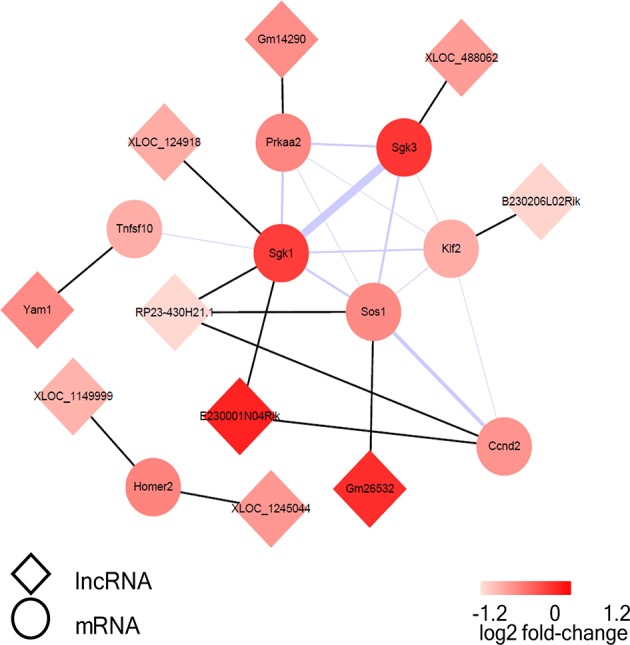
The visualization of the lncRNA/FoxO gene co-expression network in FoxO pathways. The circular nodes represent the FoxO-genes, and the diamond nodes represent the FoxO-lncRNAs. The black lines show connections between lncRNAs and their target mRNAs; the purple line shows integration of protein-protein interactions and the thicker lines represent the larger combined score.